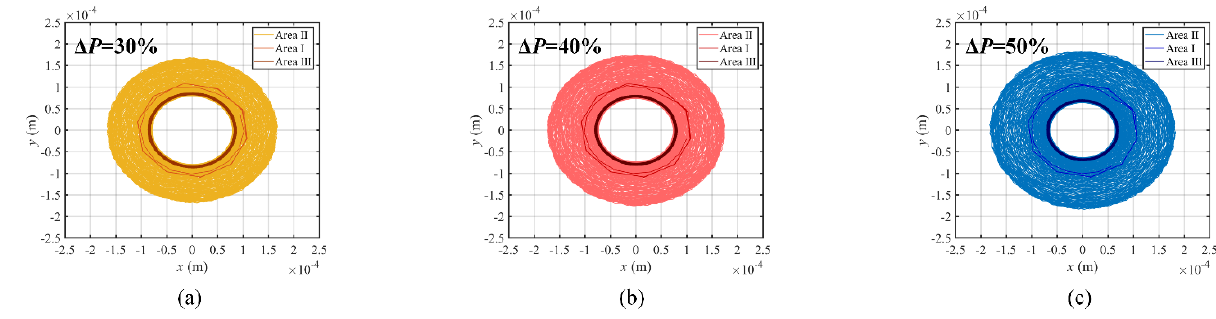
Figure 11. The axis trajectory of the hydro-turbine runner under different sudden load increasing amounts. ( a ) ∆ P = 30%; ( b ) ∆ P = 40%; ( c ) ∆ P = 50%.